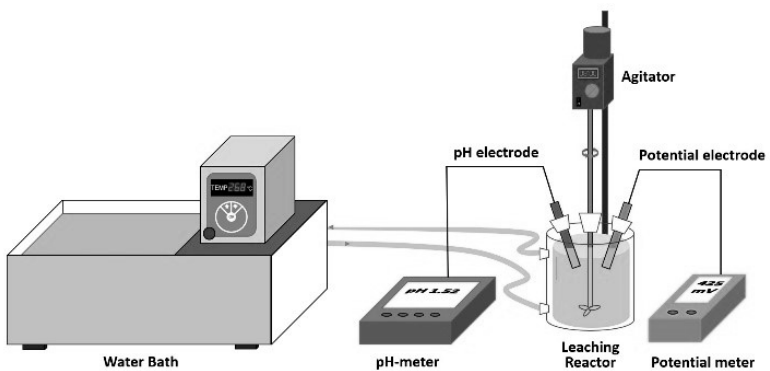
Figure 1. Scheme of the magnetic stirrer leaching system. Sample solutions (3 mL aliquots) were periodically withdrawn for chemical